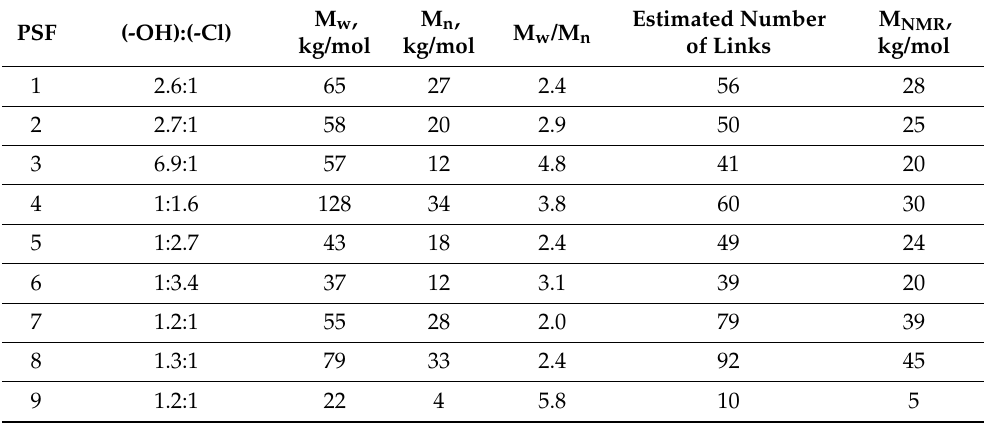
Table 3. Molecular weight characteristics of synthesized PSF determined by the GPC method and by estimates made based on the NMR